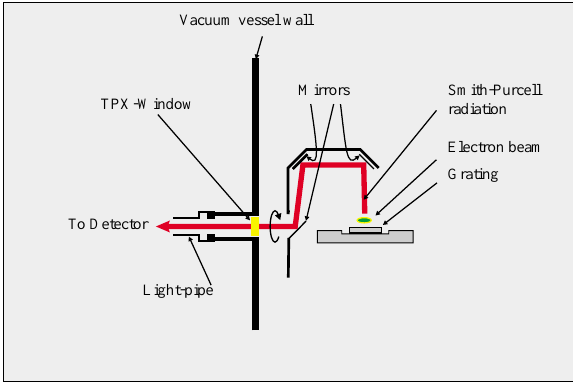
FIG. 1. (Color) Schematic of light-collection